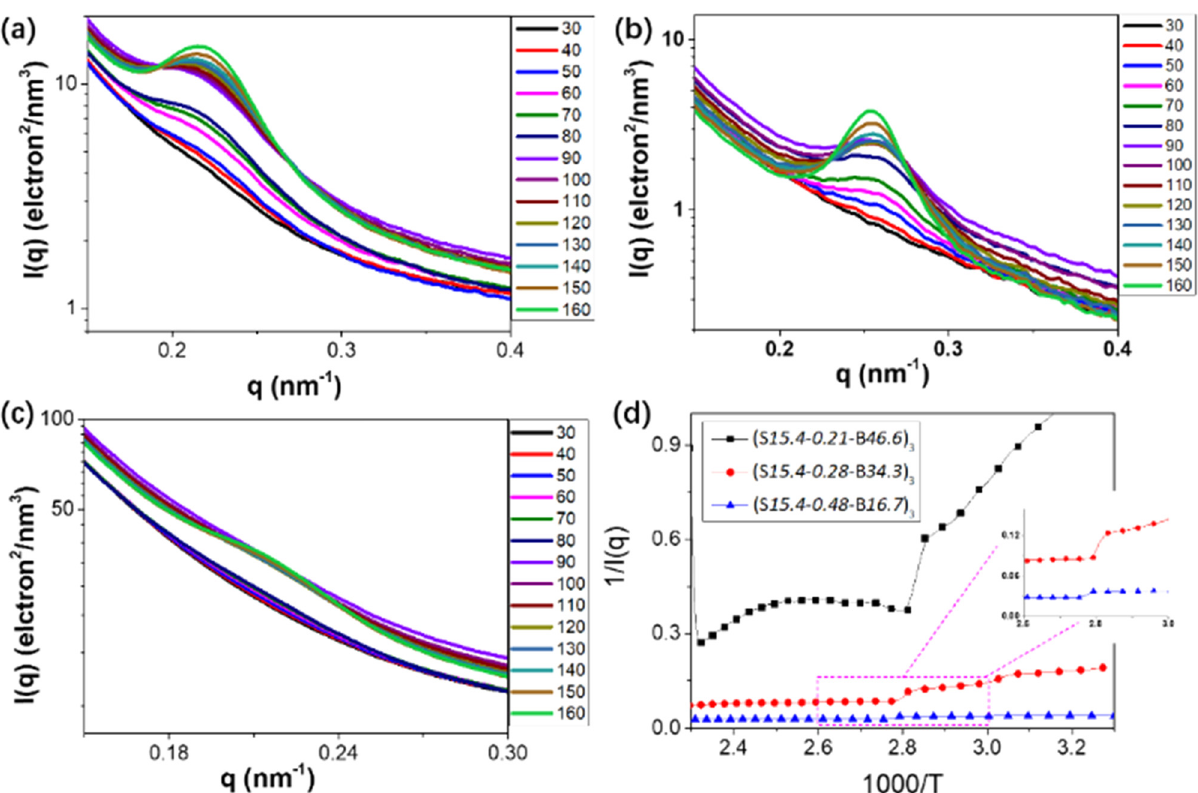
Figure 6: SAXS intensity pro fi les for the three - armed star block copolymers: ( a ) ( S 15.4 - 0.48 - B 16.7 ) 3 , ( b ) ( S 15.4 - 0.28 - B 34.3 ) 3 , and ( c ) ( S 15.4 - 0.21 - B .6 ) ff erent detection temperatures ( from 30°C to 160°C ) . ( d ) Inverse of the maximum intensity ( 1/ I ( q * )) at the peak 3 at di position as a function of the inverse temperature ( 1,000/K ) for ( S 15.4 - 0.48 - B .7 ) 3 , ( S 15.4 - 0.28 - B 34.3 ) 3 , and ( S 15.4 - 0.21 - B 46.6 ) 3